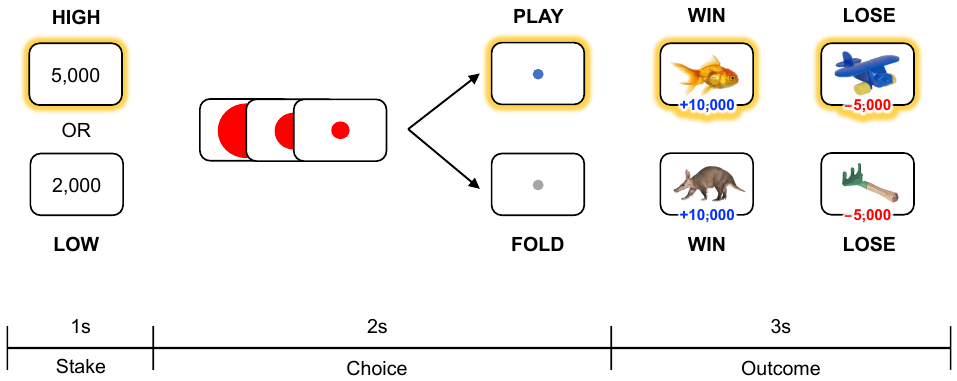
Figure 2. Task structure of the card-guessing task. Participants were first provided the amount of the ante for a given trial, which indicated whether the stakes were high or low. Then, within a 2-s window, participants chose whether to play or to fold. For example, after recognizing that the stakes are high, participants may choose to engage in gambling, which results in either winning or losing a set amount of money determined by the ante (highlighted in